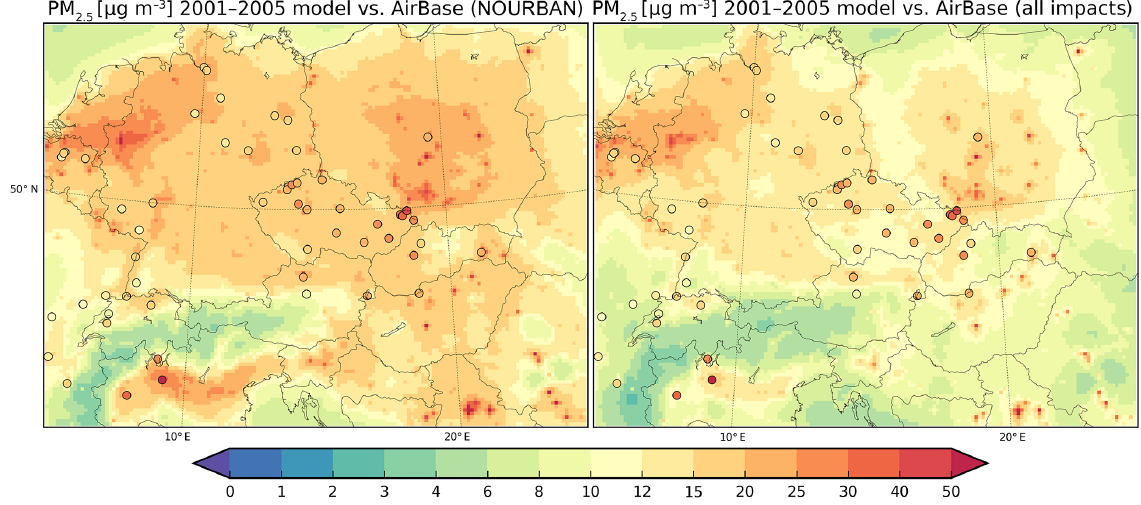
Figure 3. Absolute surface PM 2 . 5 concentrations in µgm − 3 averaged over the 2001–2005 JJA period for the NOURBAN experiment (i.e., without urban surface meteorological effects) and with the experiment for which all urban meteorological effects are considered. Circles represent measured values from the AirBase database.